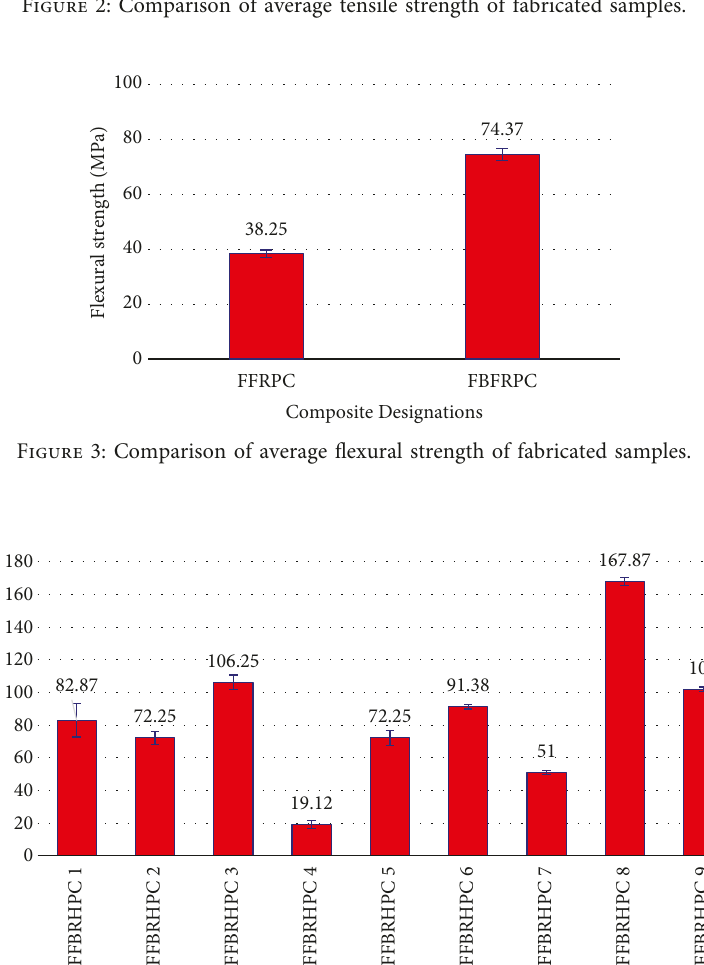
Figure 2: Comparison of average tensile strength of fabricated samples.